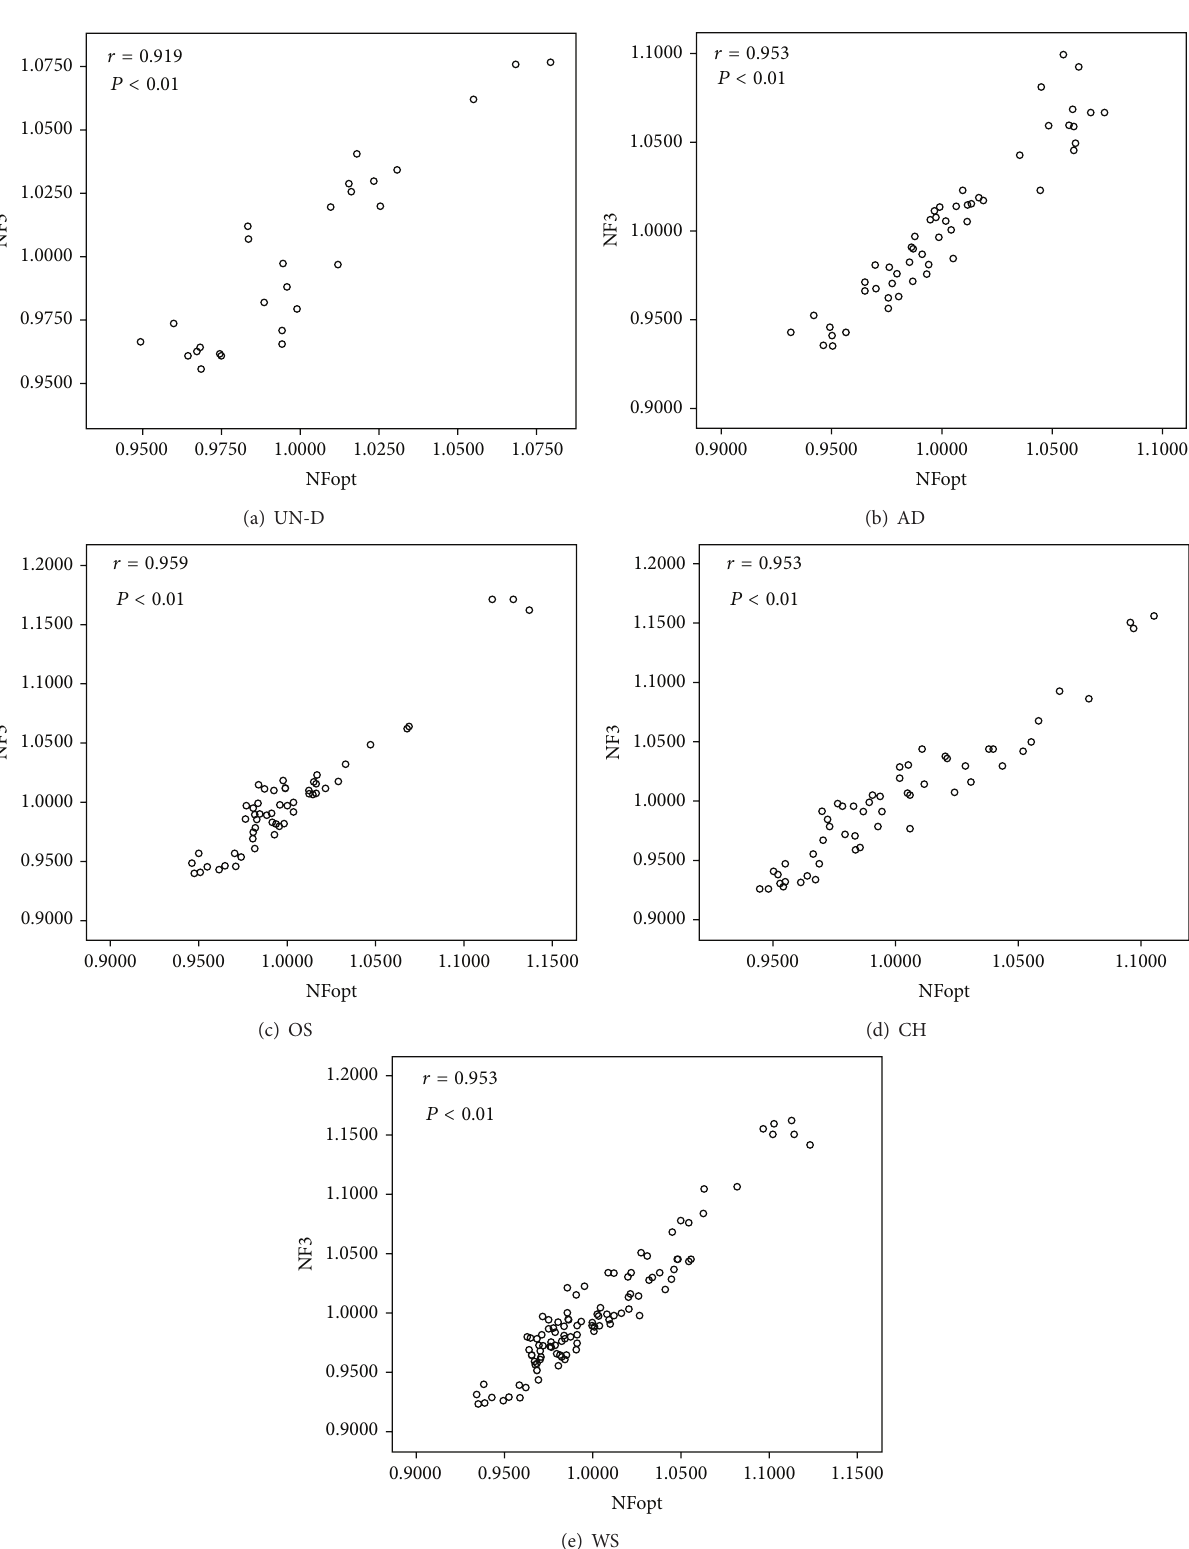
Figure 7: Correlation between NF 3 and NF opt by using Pearson’s correlation. Pearson’s correlation was applied between the three most stable reference genes at the lowest M value and optimal number of reference genes in the lowest pairwise variation V by geNorm software. The value about r > 0.9 ( 𝑃 < 0.01 ) indicates high correlation between two groups. Pearson’s correlation for (a) undifferentiated status of BMSCs, AMSCs, and SMSCs and (b–d) differentiated cells into adipocytes, osteocytes, and chondrocytes, respectively. (e) Whole status of